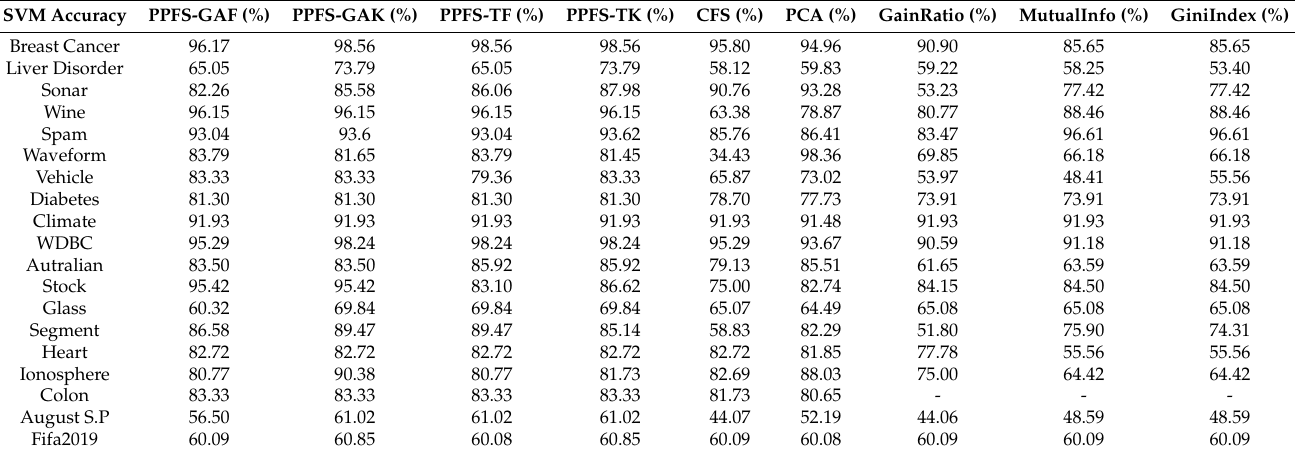
Table 7. The Classification accuracy provided by SVM Classifier after applying the 4 PPFS, CFS, and PCA feature selec- tion